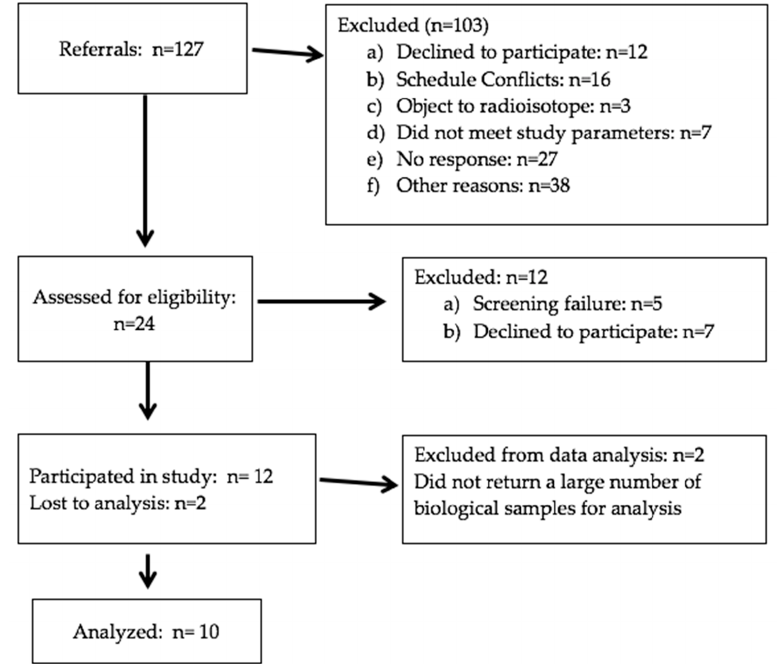
Figure A1. Flowchart of participants’ progress through study.